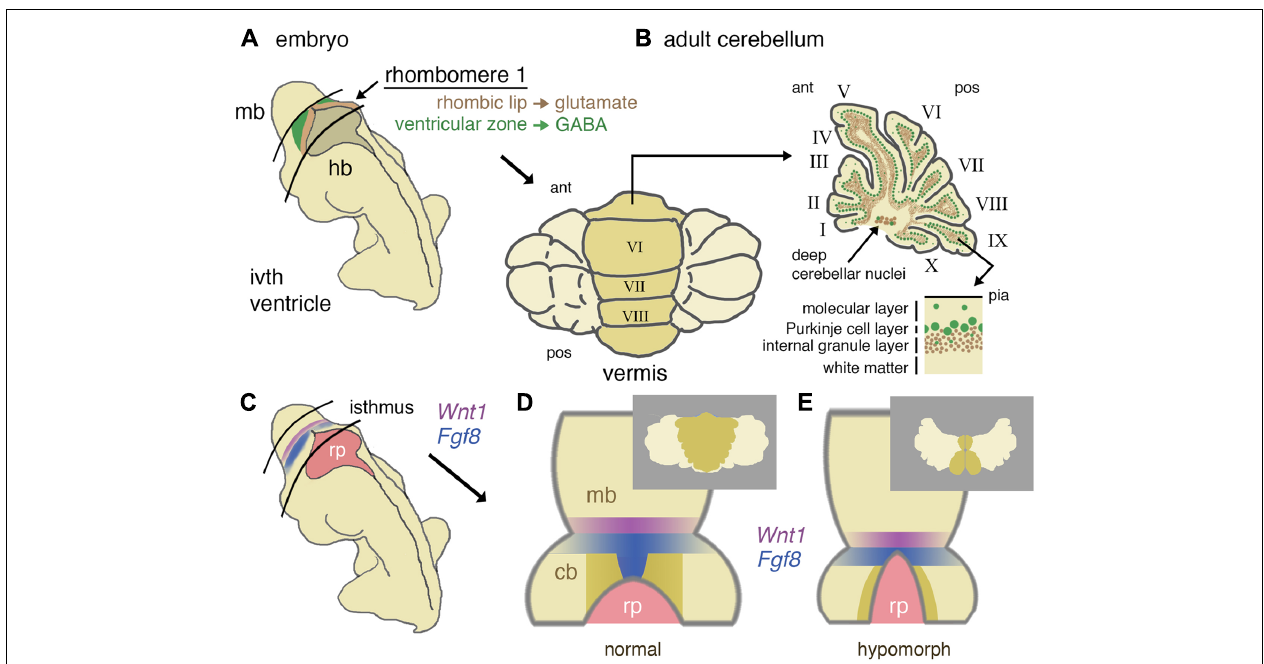
a population of inhibitory Golgi cells. Deep cerebellar nuclei (GABA-ergic and glutamatergic neurons) lie within the white matter. (C) Schematic diagram showing the location of the isthmus organizer at the midbrain/hindbrain boundary with respect to the fourth ventricle roof plate (rp) and the expression domains of Wnt1 (purple) and Fgf8 (blue). (D) Dorsal schematic view of the isthmus region showing with darker shading the approximate region where progenitors of the cerebellar vermis reside, as based on inducible fate-mapping studies (Sgaier etal., 2005).The translation of this dorsal rhombomere 1 territory into adult vermis is shown inset . (E) Altered morphology of the isthmic region and reduced cerebellar size in a hypomorph with an altered function of the isthmic organizer due to diminished FGF signaling. Loss of vermis progenitors is concomitant with the expansion of the roof plate (adapted from Basson etal., 2008).The consequences for vermal morphogenesis in the adult are shown inset .